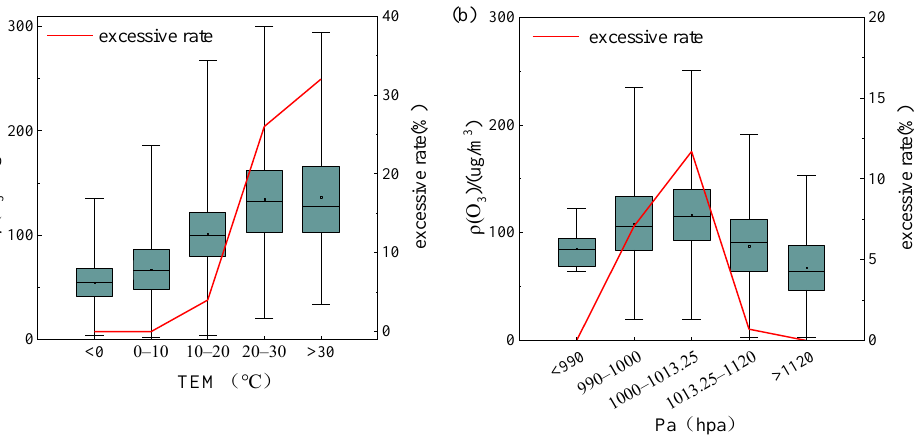
Figure 9. ( a ) O 3 concentrations and excessive rate under different temperature conditions, ( b ) O 3 concentrations and excessive rate under different air pressure conditions.